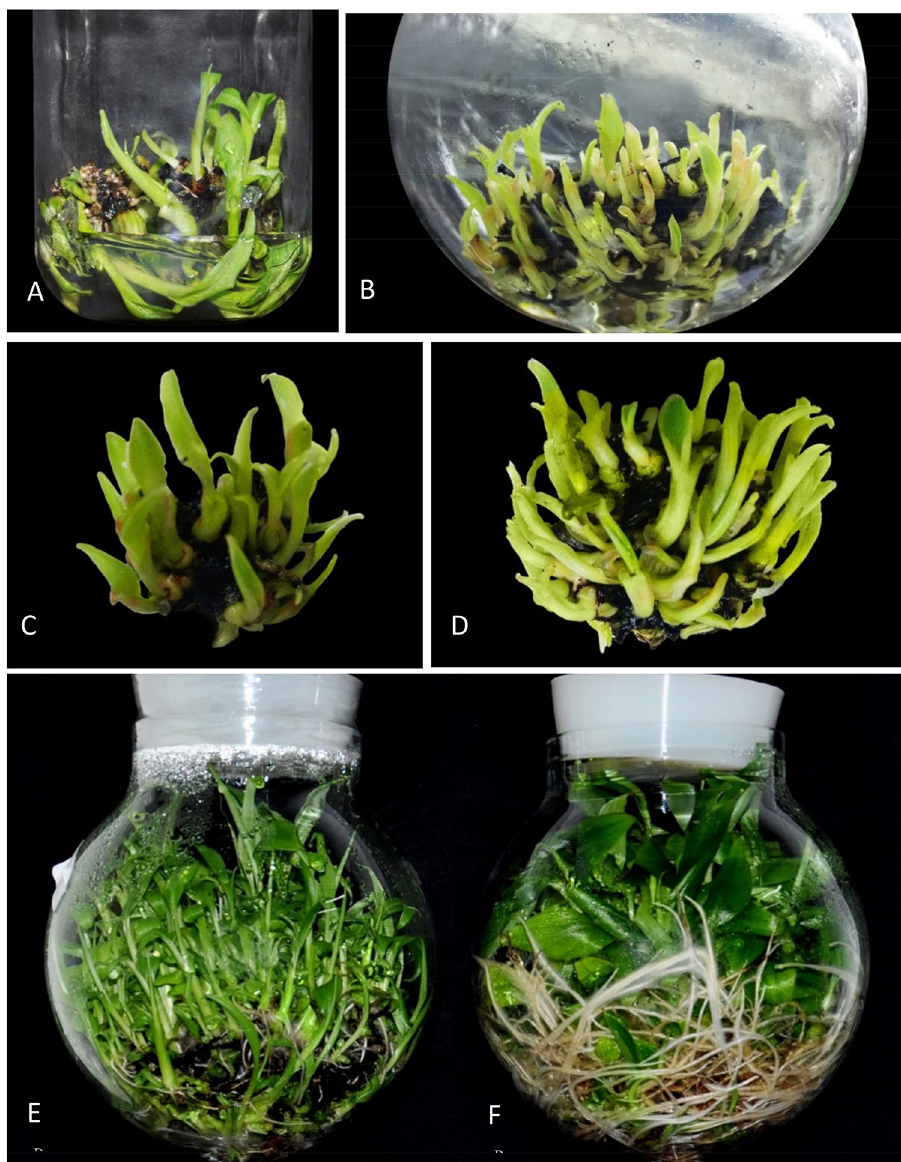
Figure 7. Micropropagation of banana cv. Rasthali in temporary immersion bioreactor. ( A ) Multiple shoots in semisolid culture system. ( B ) Multiple shoots in TIB system. ( C ) Multiple shoot cluster grown in semisolid medium. ( D ) Multiple shoot cluster grown in TIB system. ( E ) Mass multiplied plantlets in TIB system. ( F ) Rooted plantlets in TIB (Images arranged in Adobe Photoshop